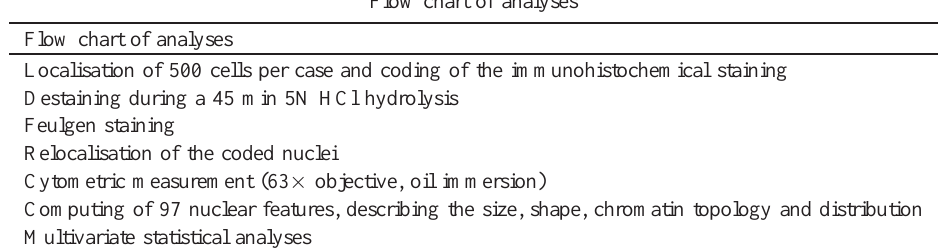
Table 4 Flow chart of